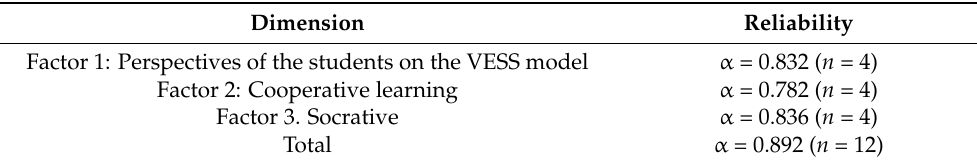
Table 2. Internal consistency of the instrument. Dimension Reliability Factor 1: Perspectives of the students on the VESS